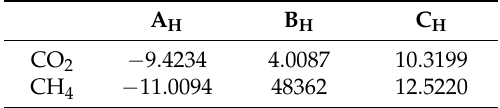
Table 1. Parameters of dimensionless Henry’s constant (k H ) to be substituted in Equation (3)